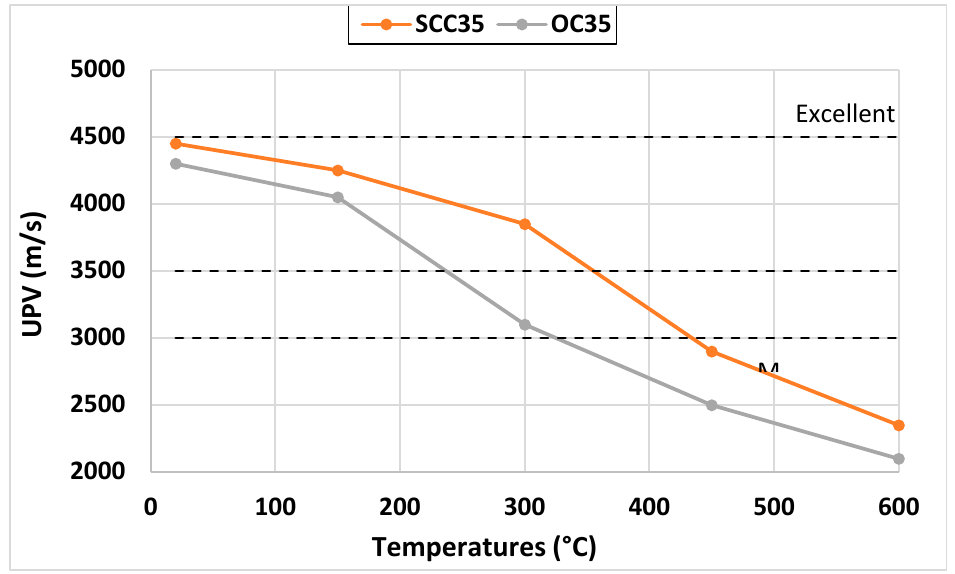
Figure 13. Effect ofthe heating-cooling cycle on the UPV.